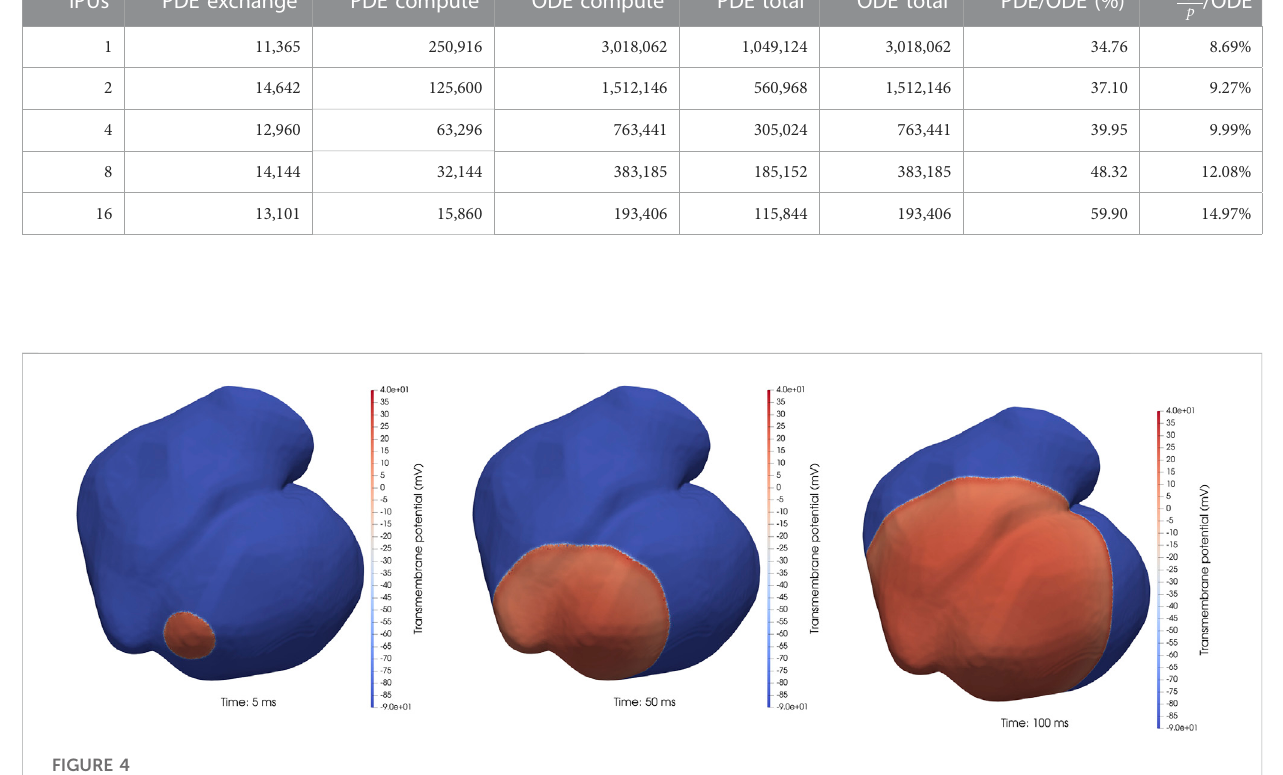
TABLE 2 Breakdown of different algorithmic phases (in number of clock cycles) for the strong-scaling experiments using the heart04 mesh. The PDE per ODE factor p is always four, i.e., four PDE steps per ODE step. IPUs PDE exchange